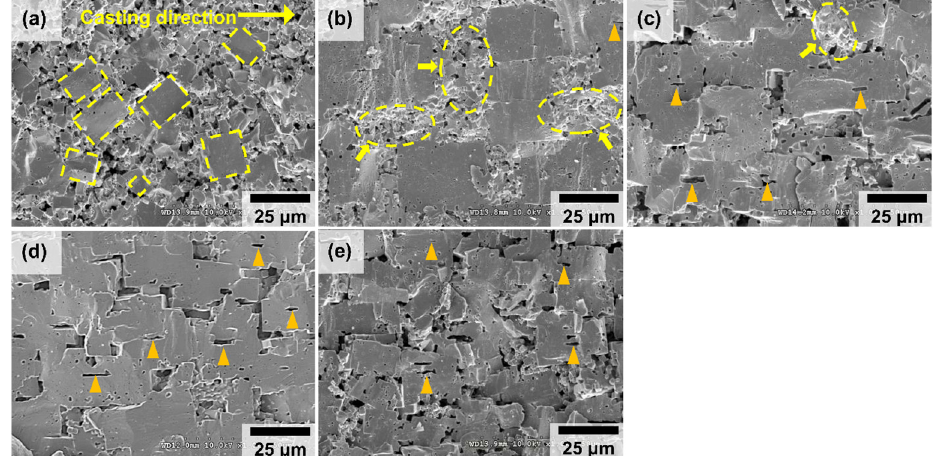
Figure 2. SEM images of the cross-sectional fractured surface of the NKNS-0.02SZ-0.02BAZ + y mol% NN thick films with ( a ) y = 0.0, ( b ) y = 1.0, ( c ) y = 2.0, ( d ) y = 3.0, and ( e ) y = 5.0. Polarization versus electric field ( P-E ) hysteresis curves were obtained for the NKNS-0.02SZ-0.02BAZ + y mol% NN thick films (0.0 ≤ y ≤ 5.0) to study the effect of texturing on